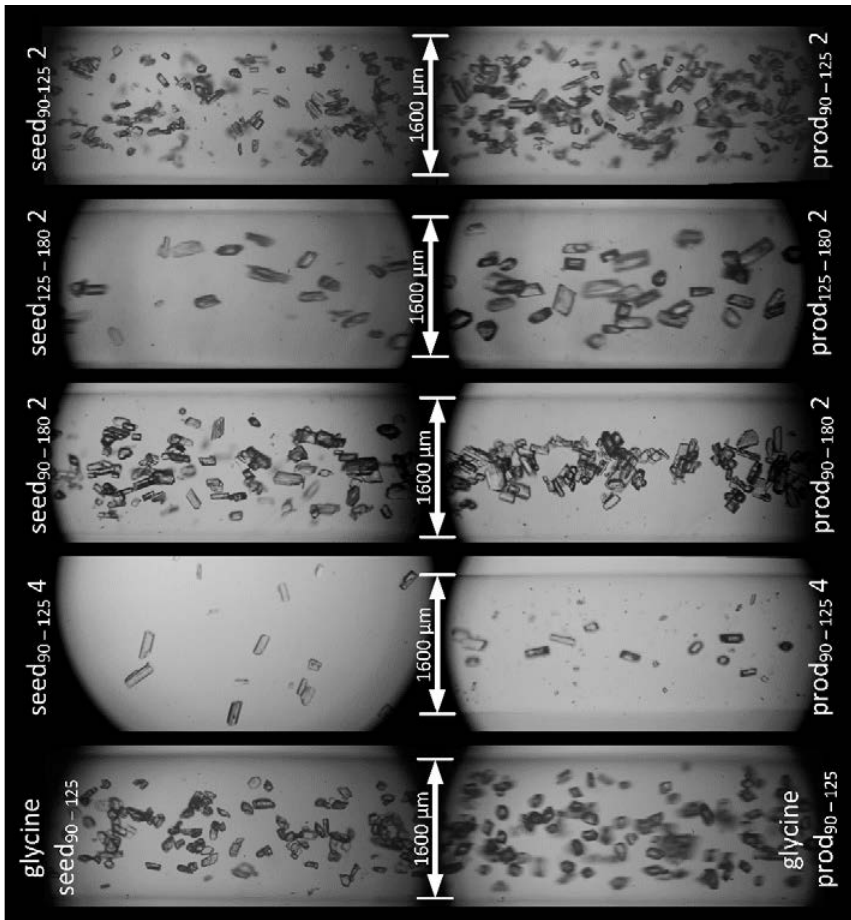
Figure 6. Microscopic pictures in the non-invasive measurement flow-cell for crystal growth experiments. Exception: seed 90-125 4, here the seed crystals photo is taken in a Petri dish.